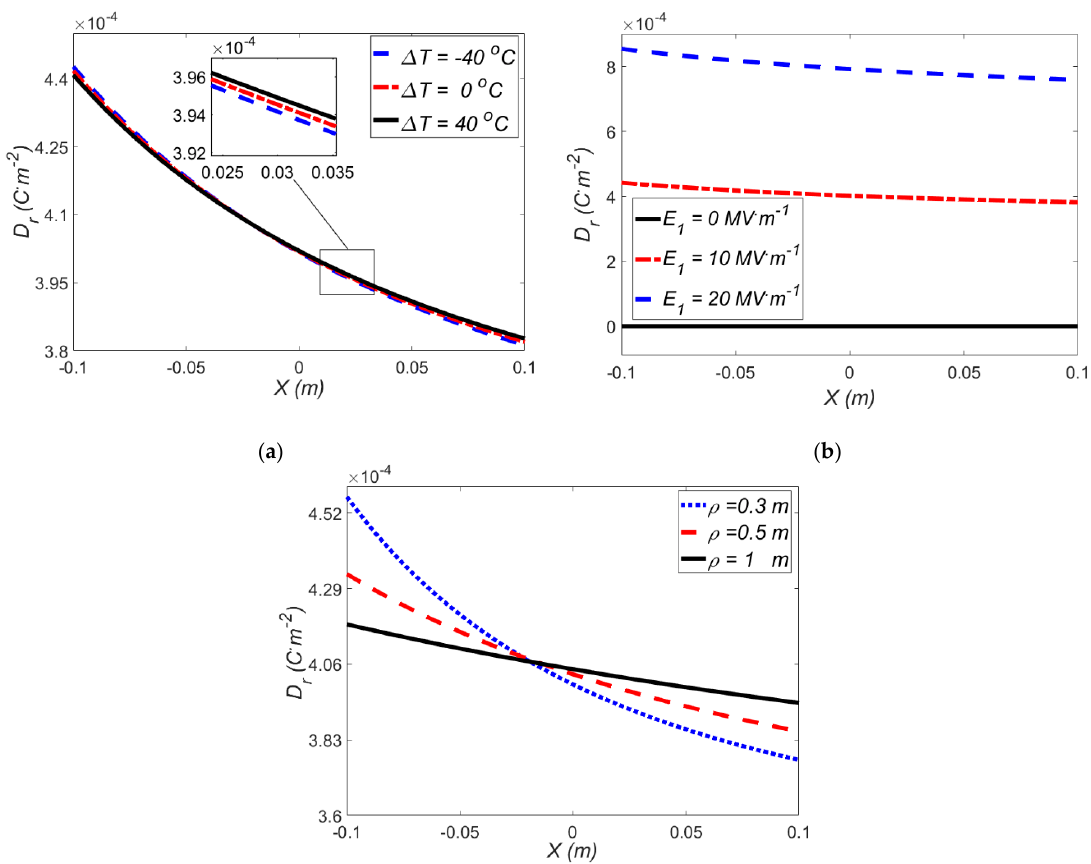
Figure 10. Variations of electric induction for exp-exp model with different ( a ) temperature gradients at E 1 = 10 MV·m − 1 , ρ = 0.4 m; ( b ) electric fields at Δ T = 0 °C, ρ = 0.4 m; ( c ) applied mean radius of curvature at Δ T = 0 °C and E 1 = 10 MV·m − 1